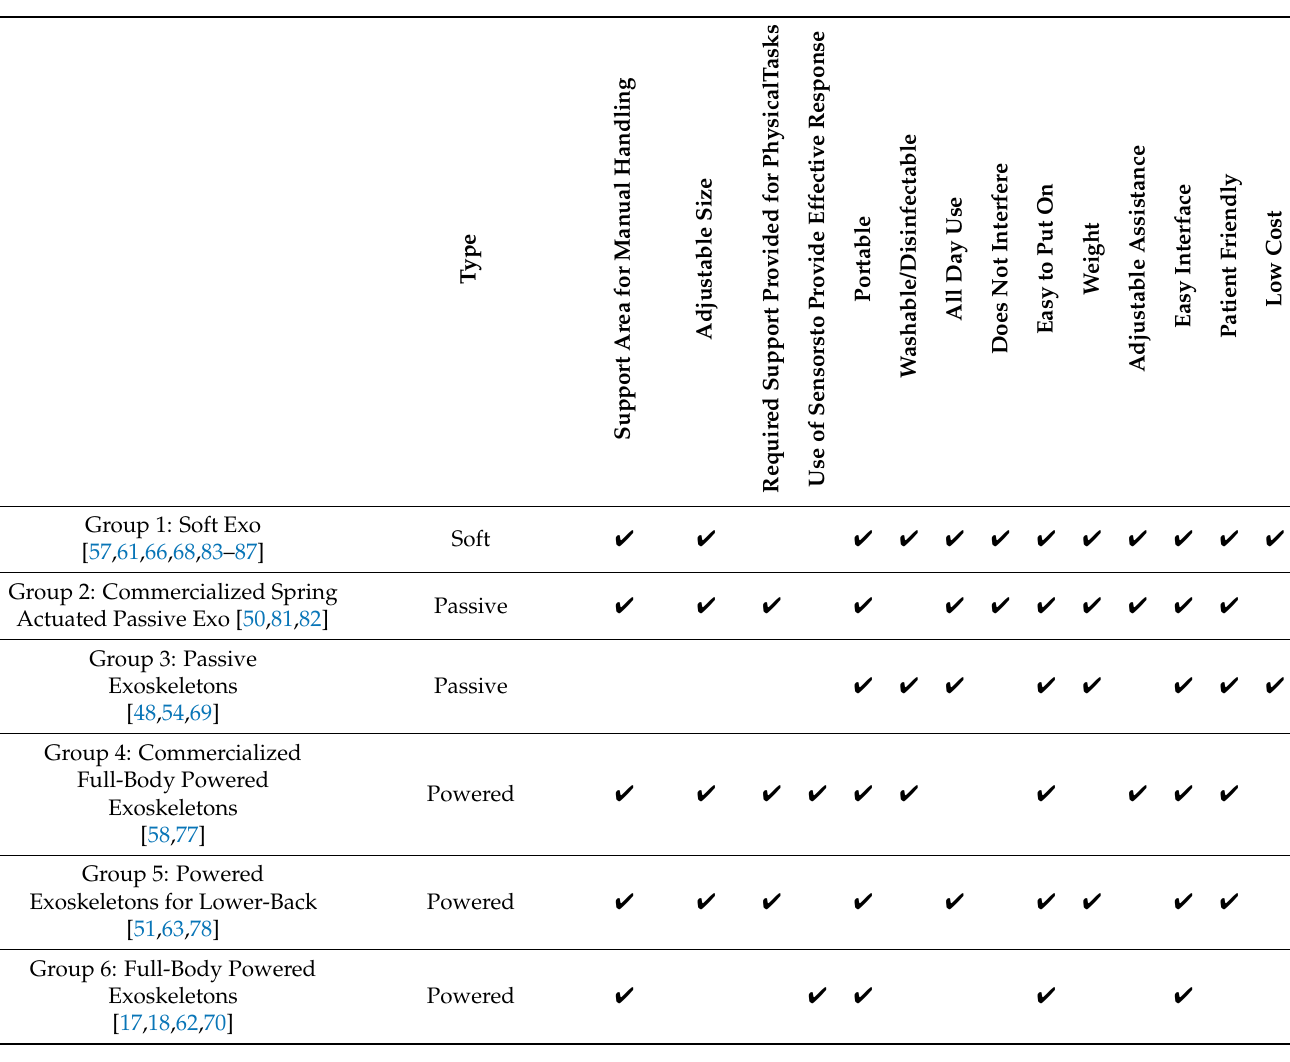
Table 5. Needs of nurses versus to what extent they are addressed by the available exoskeletons re- viewed. The sign ( (cid:52) ) indicates that the need has been addressed by the corresponding set of literature.